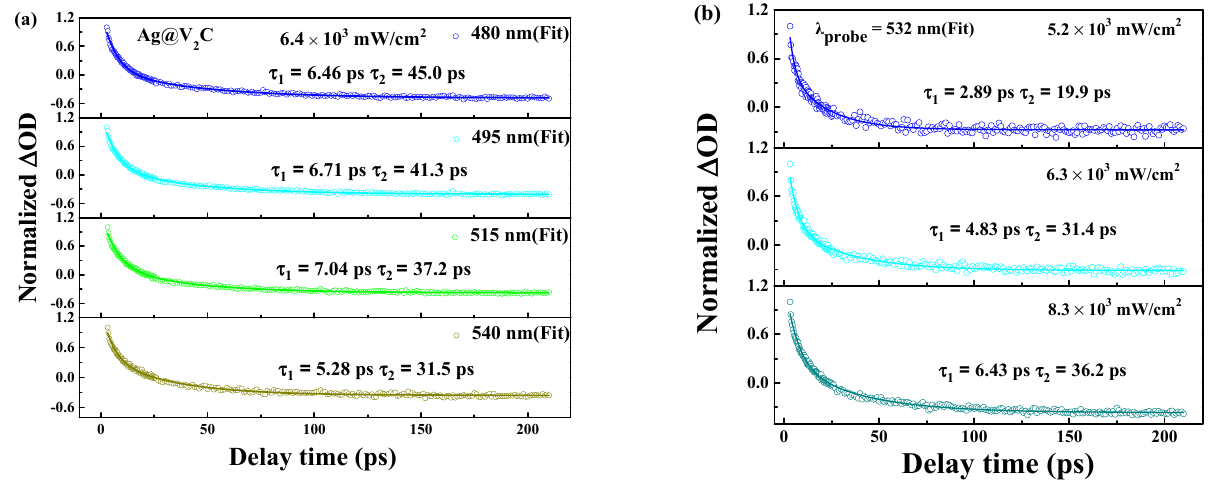
Figure 5. ( a ) Carrier dynamics (at 400 nm pump) curves for Ag@V 2 C nanosheet at various probe wavelengths of 480, 495, 525, 515 and 540 nm, respectively. The scatters are experimental data while the solid lines are theoretical fit generated with pump fluence fixed at 6.4 × 10 3 mW/cm 2 . ( b ) Carrier dynamics curves (at 400 nm pump) at different pump fluences 5.2 × 10 3 , 6.3 × 10 3 and 8.3 × 10 3 mW/cm 2 with a probe wavelength fixed at 532 nm.